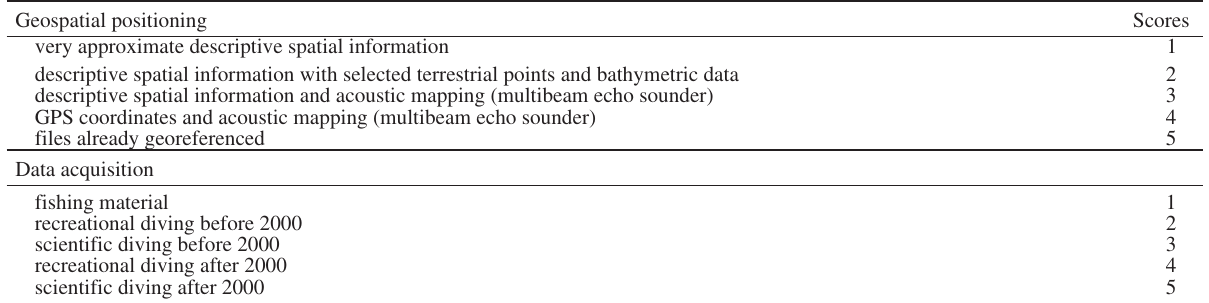
Table 1. – Scores of the dependability index (up to 5+5 points) from the literature. Geospatial